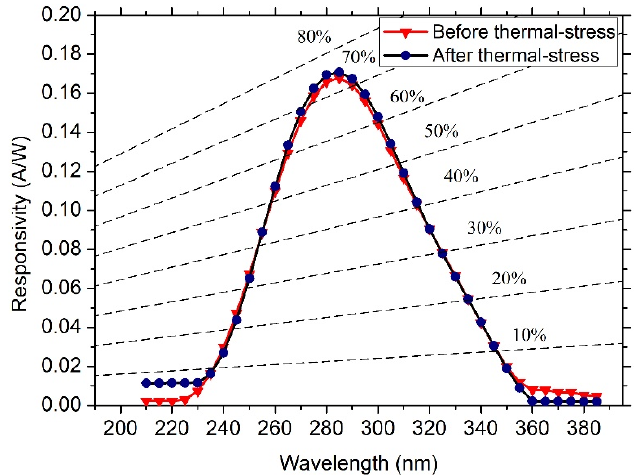
Figure 9. 4H-SiC p-i-n photodiode responsivities before and after ten cycles of measurements, from RT up to 350 °C and vice versa. During the last cycle, the DUT has been kept at T = 350 °C for 24